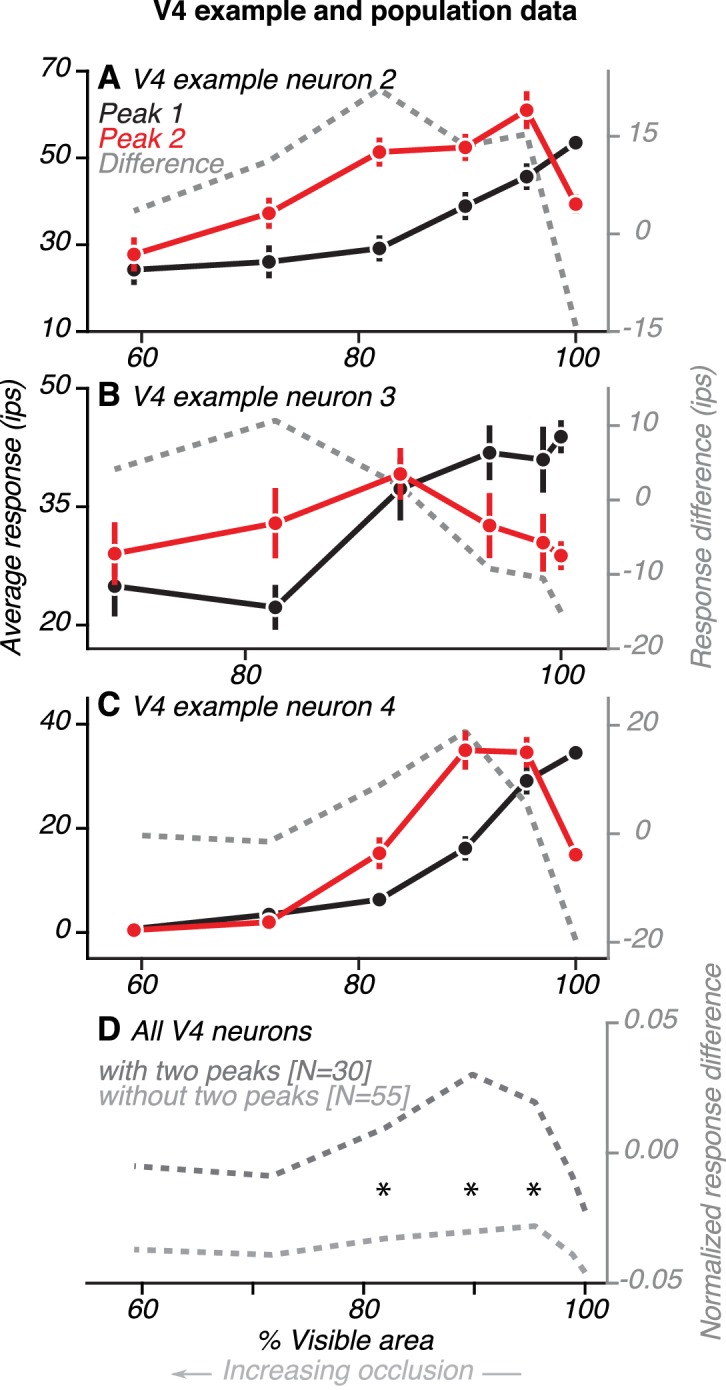
Comparison of V4 responses during the first and second peaks.(A) Data from one example V4 neuron with two peaks (same neuron as in Figure 4D). Average responses (left ordinate) were measured within a 30 ms window centered on the first and second peaks, relative to the preceding baseline (85–115 ms before test stimulus onset). Difference in responses (right ordinate) between the first and second peaks (gray line) is shown. During the first peak (black), responses were strongest for the unoccluded shape (100% visible area) and declined for higher occlusion levels (<100% visible area). During the second peak (red), responses were strongest for intermediate levels of occlusion. Response difference was an inverted U-shaped curve, with a negative value for the unoccluded stimulus and positive for all levels of occlusion. (B–C) Data for two other V4 neurons (same neurons as in Figure 5A–B, respectively). (D) Population average of the difference in responses between first and second peak for neurons with (dark gray) and without (light gray) two peaks. Responses of each neuron were first normalized by the maximum across time and occlusion levels. Then, for each neuron and at each occlusion level, we measured the difference in response between two time points: during the initial transient (69–99 ms after test stimulus onset) and at a later time in the sustained response phase (199–229 ms after test stimulus onset). These time points are centered around the median peak time of the first and second peaks, respectively. For neurons with two peaks, the average response difference between first and second peaks followed a U-shaped curve, with positive values for intermediate levels of occlusion. For neurons without two peaks, the difference curve was flat and negative for all levels of occlusion. Asterisks mark occlusion levels for which the average response difference curve was significantly greater for neurons with two peaks (t Test, p<0.05).